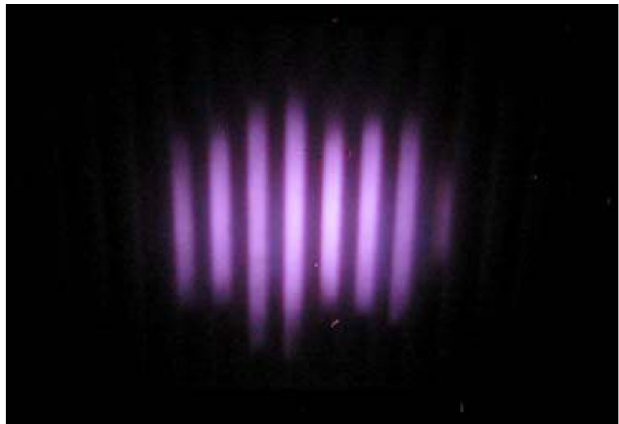
FIG. 9. (Color) Microwave breakdown inside diffraction grating (distance between plasma layers is equal 6.9 mm).